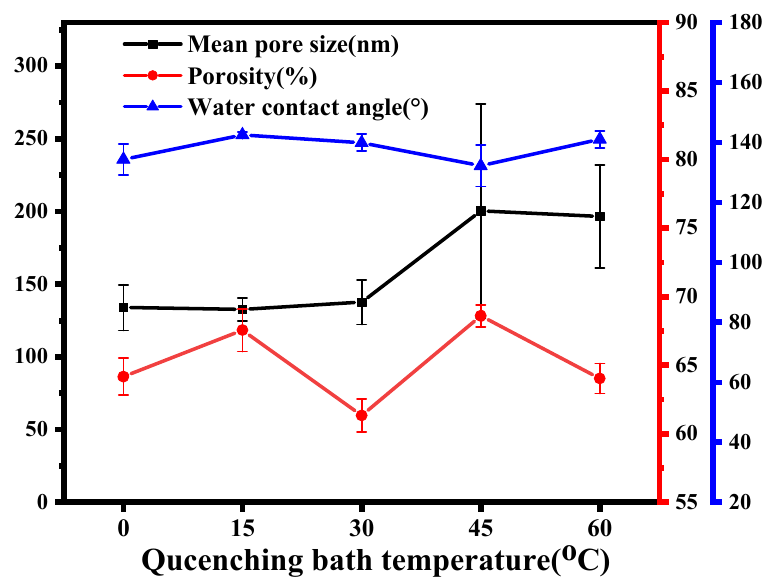
Figure 11. Mean pore size, porosity and water contact angle of ECTFE membranes prepared at different cooling rates.